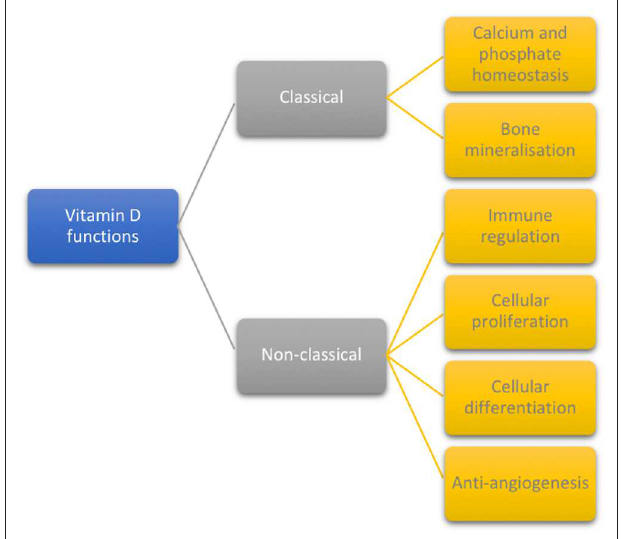
FIGURE 1 | Classical and non-classical functions of vitamin